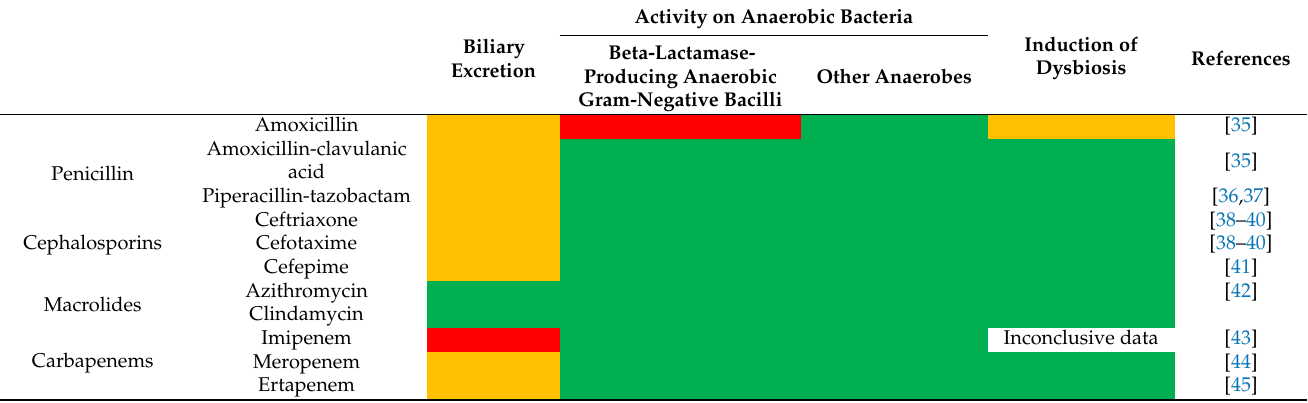
Table 1. Impact of antibiotic on gut